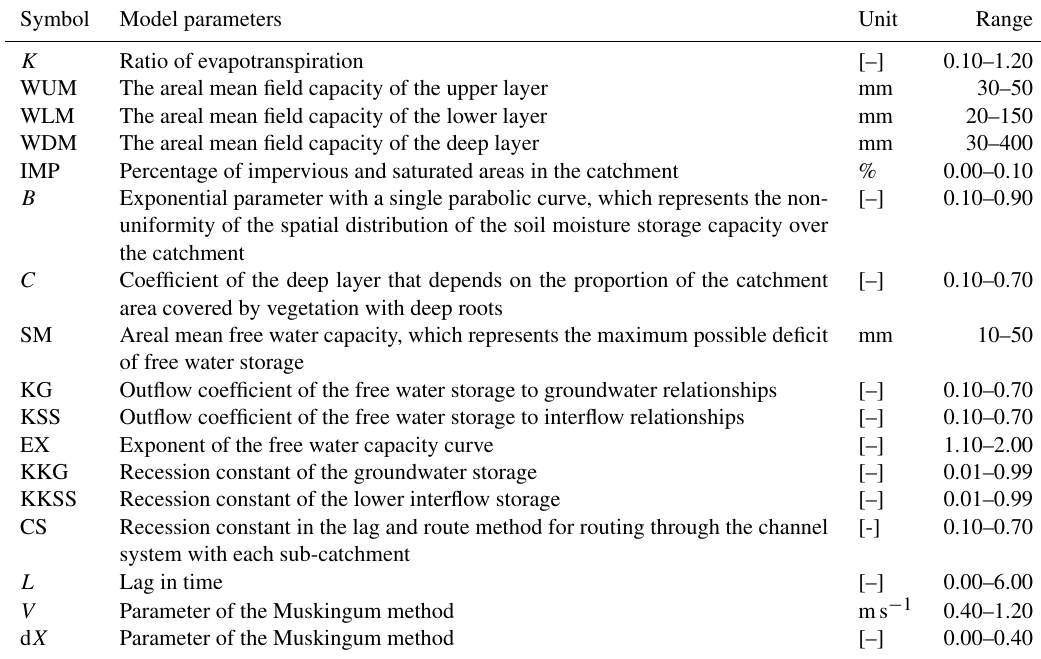
Table 1. The XAJ model parameters used in the Pontiac